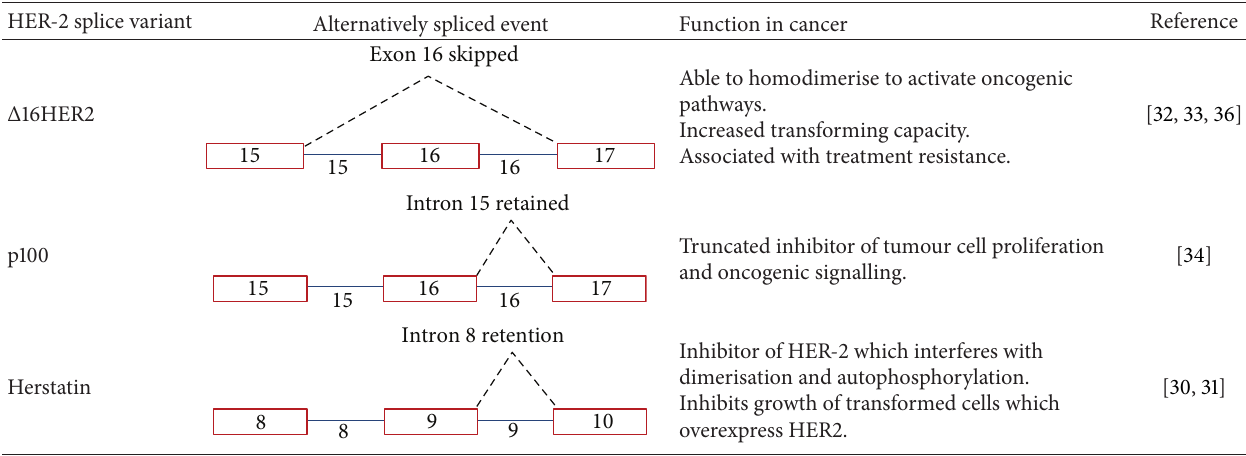
Table 1: HER-2 spliced variants and their role in